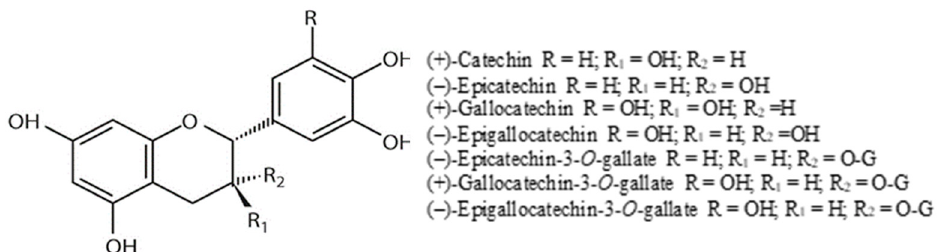
Figure 6. Structures of flavan-3-ol monomers present in grapes.